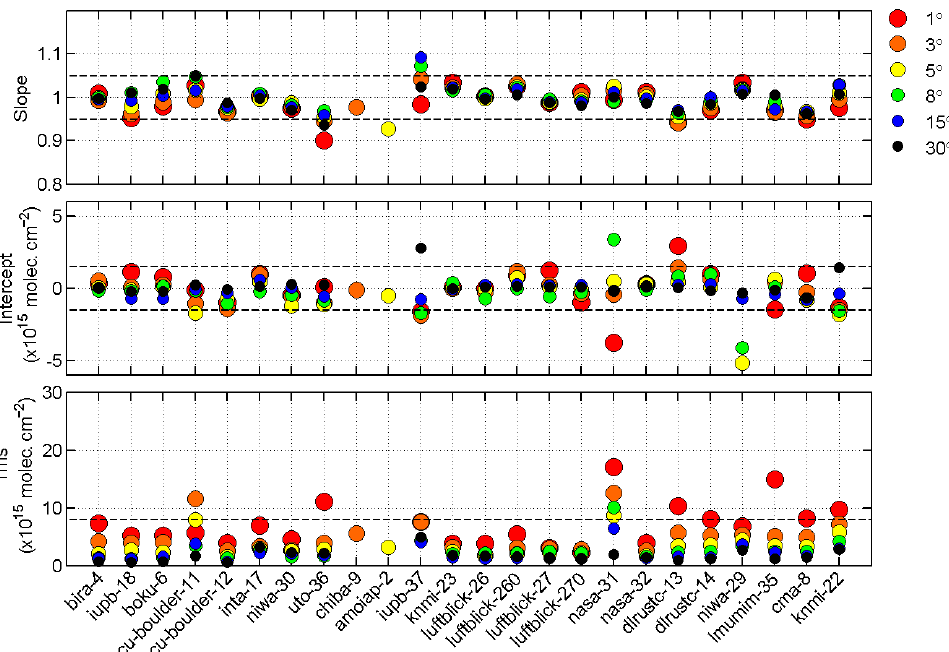
Figure 17. Slope, intercept and rms of regression plots against the median dSCD reference, for each of the 24 instruments measuring NO 2 in the visible wavelength range (as shown in Fig. 10). The values are colour-coded corresponding to the elevation angles (1 to 30 ◦ ). Apart from a couple of exceptions (chiba-9, amoiap-2), most instruments measure the whole range of elevation angles. The dashed lines indicate the limits when comparing the values of the parameters for the different instruments with the aim of identifying outliers in a more objective way. Section 4 and Fig. 18 explain in more detail how the actual values of the limits were selected, and the values are listed in Table